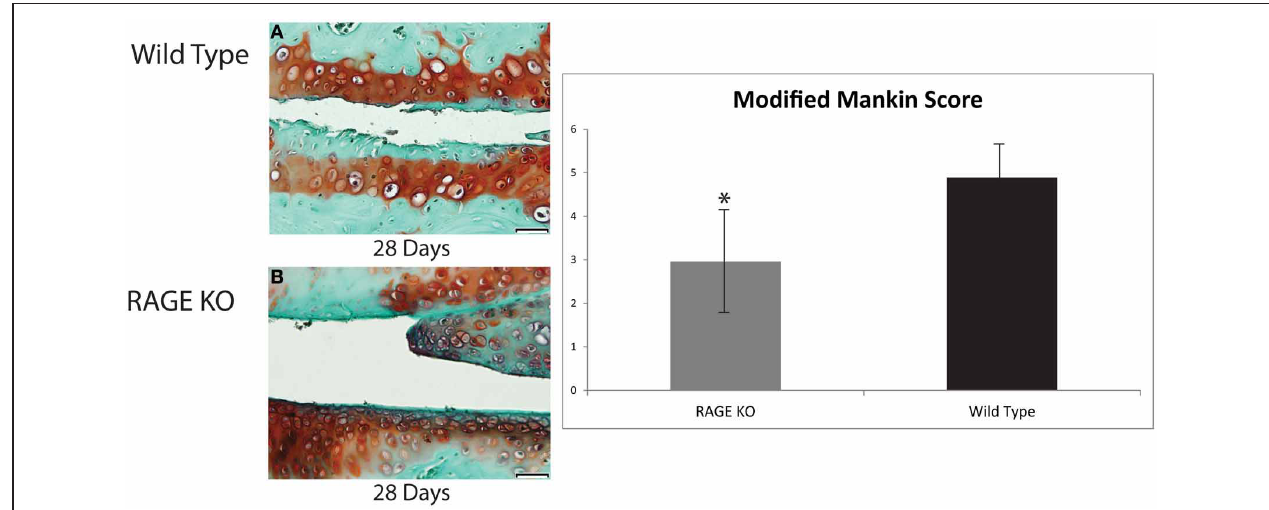
FIGURE 1 | Articular cartilage degradation from both wild type and RAGE KO samples was objectively evaluated using a modified Mankin score by two blind scorers. Tissue samples were collected from Wild Type (A) and RAGE KO (B) at 28 days post-surgery and prepared with Safarnin O/Fast Green histological stains prior to Mankin scoring. Means of RAGE KO ( n = 7) and wild type ( n = 7) modified